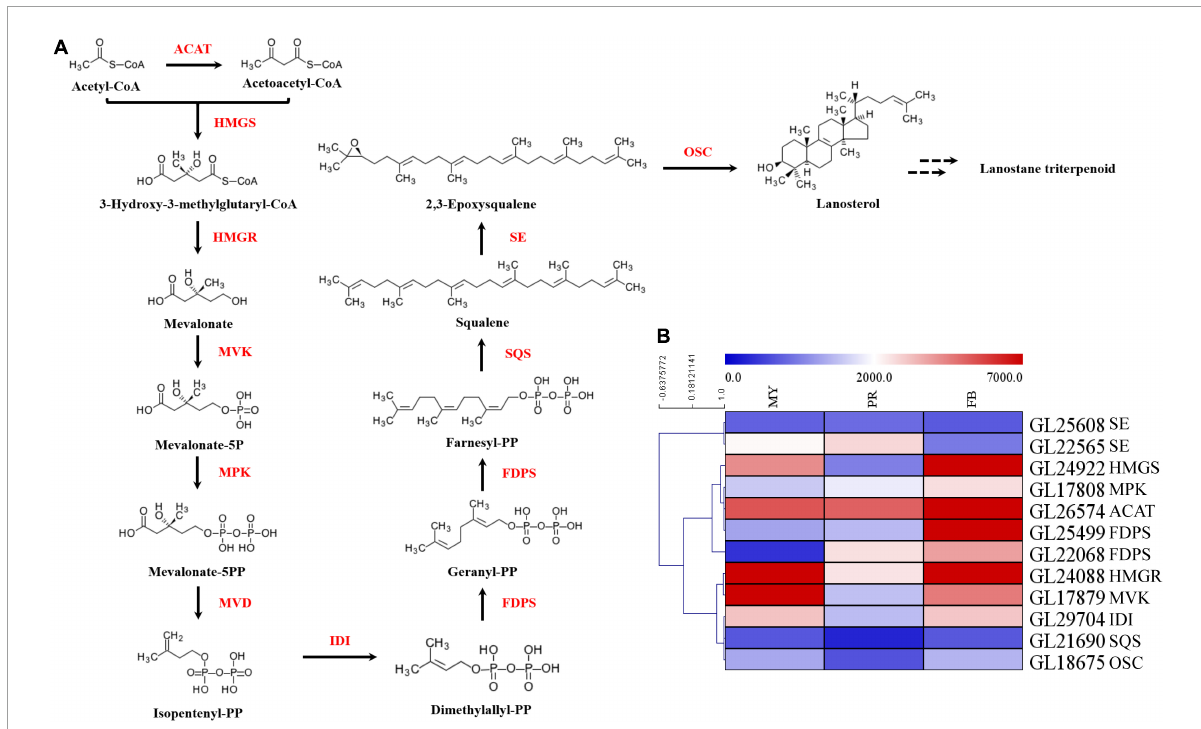
FIGURE3 The key genes of enzymes in ganoderic acid biosynthesis pathway of G. lucidum. Panel (A) the terpenoid backbone biosynthesis in G. lucidum . Red represents the enzyme, and black represents the metabolites. Panel (B) the gene expression levels of enzymes involved in terpenoid backbone biosynthesis. ATAC, acetyl-CoA -acetyltransferase; HMGS, hydroxymethylglutaryl-CoA synthase; HMGR, 3-hydroxy-3-methylglutaryl-coenzyme A reductase; MVK, mevalonate kinase; MPK, phosphomevalonate kinase; MVD,